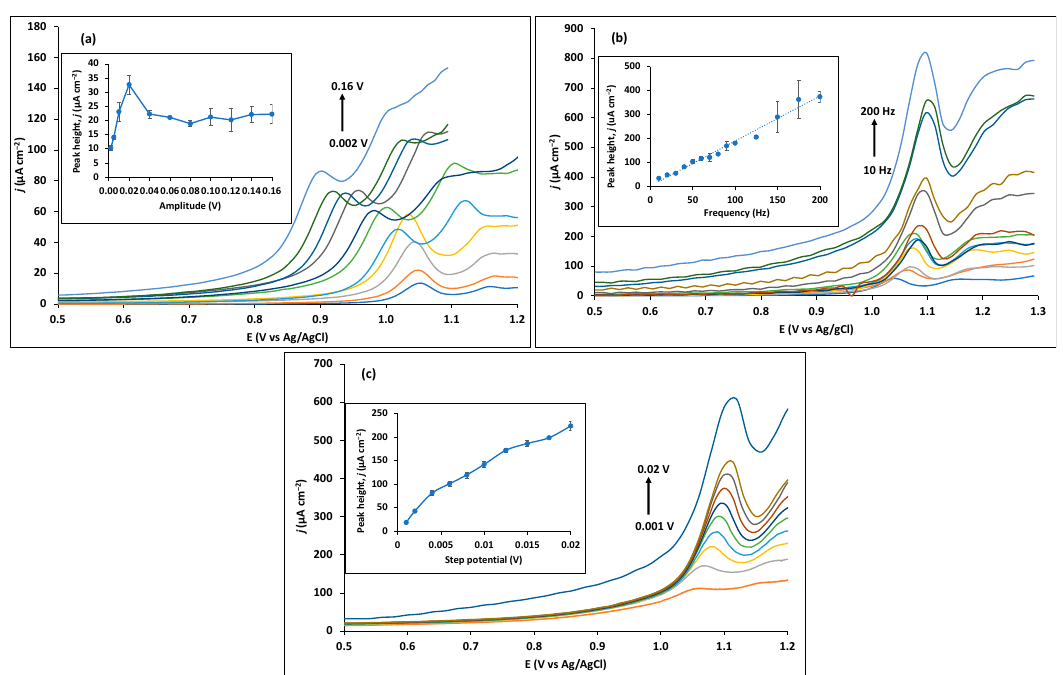
Figure 6. Optimization of SWV parameters for 10 µM trimethoprim in 0.1 M Britton–Robinson buffer pH 7. ( a ) Optimization of amplitude from 0.002 to 0.16 V. Inset: Peak height as a function of amplitude. ( b ) Optimization of frequency from 10 to 200 Hz. Inset: Peak height as a function of frequency. ( c ) Optimization of step potential from 0.001 to 0.02 V. Inset: Peak height as a function of step potential. Sensors 2023 , 23 , x FOR PEER REVIEW